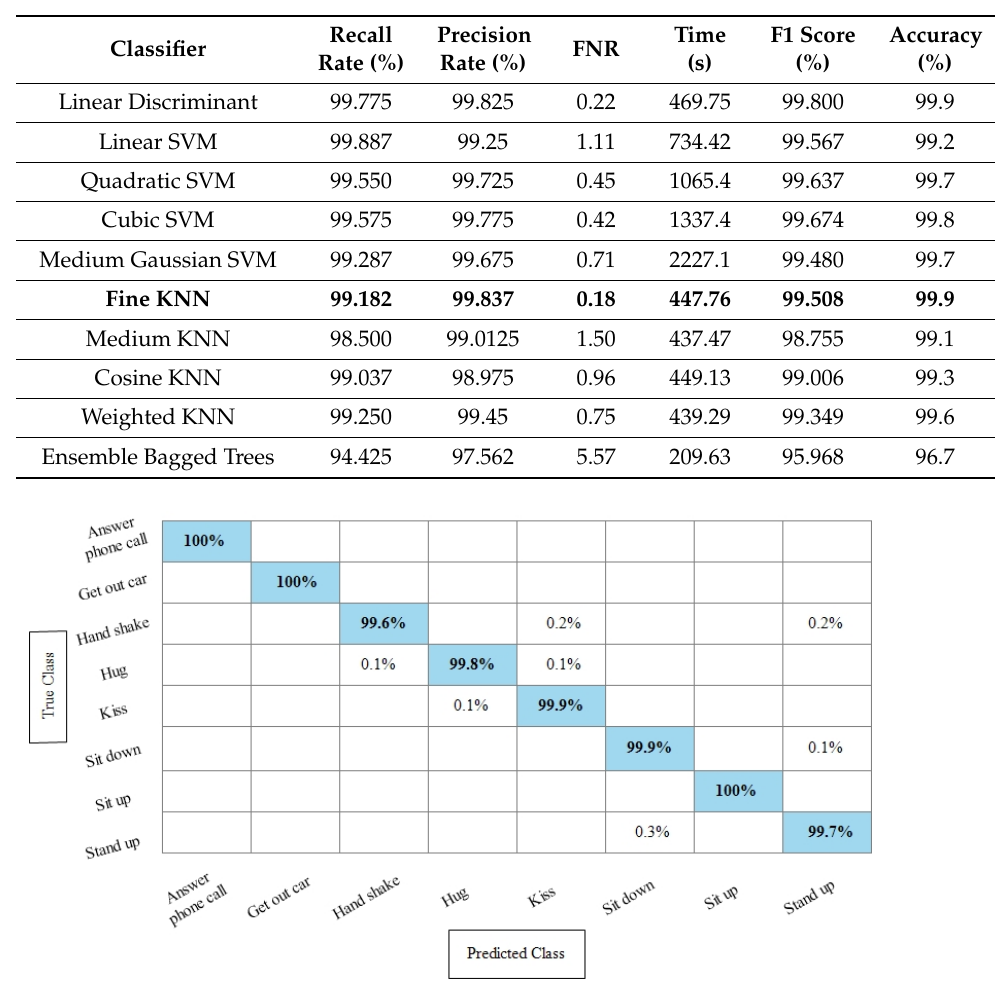
Table 4. Achieved results on Hollywood dataset after fusion of deep features using SbE approach. The bold represents the best obtained values.